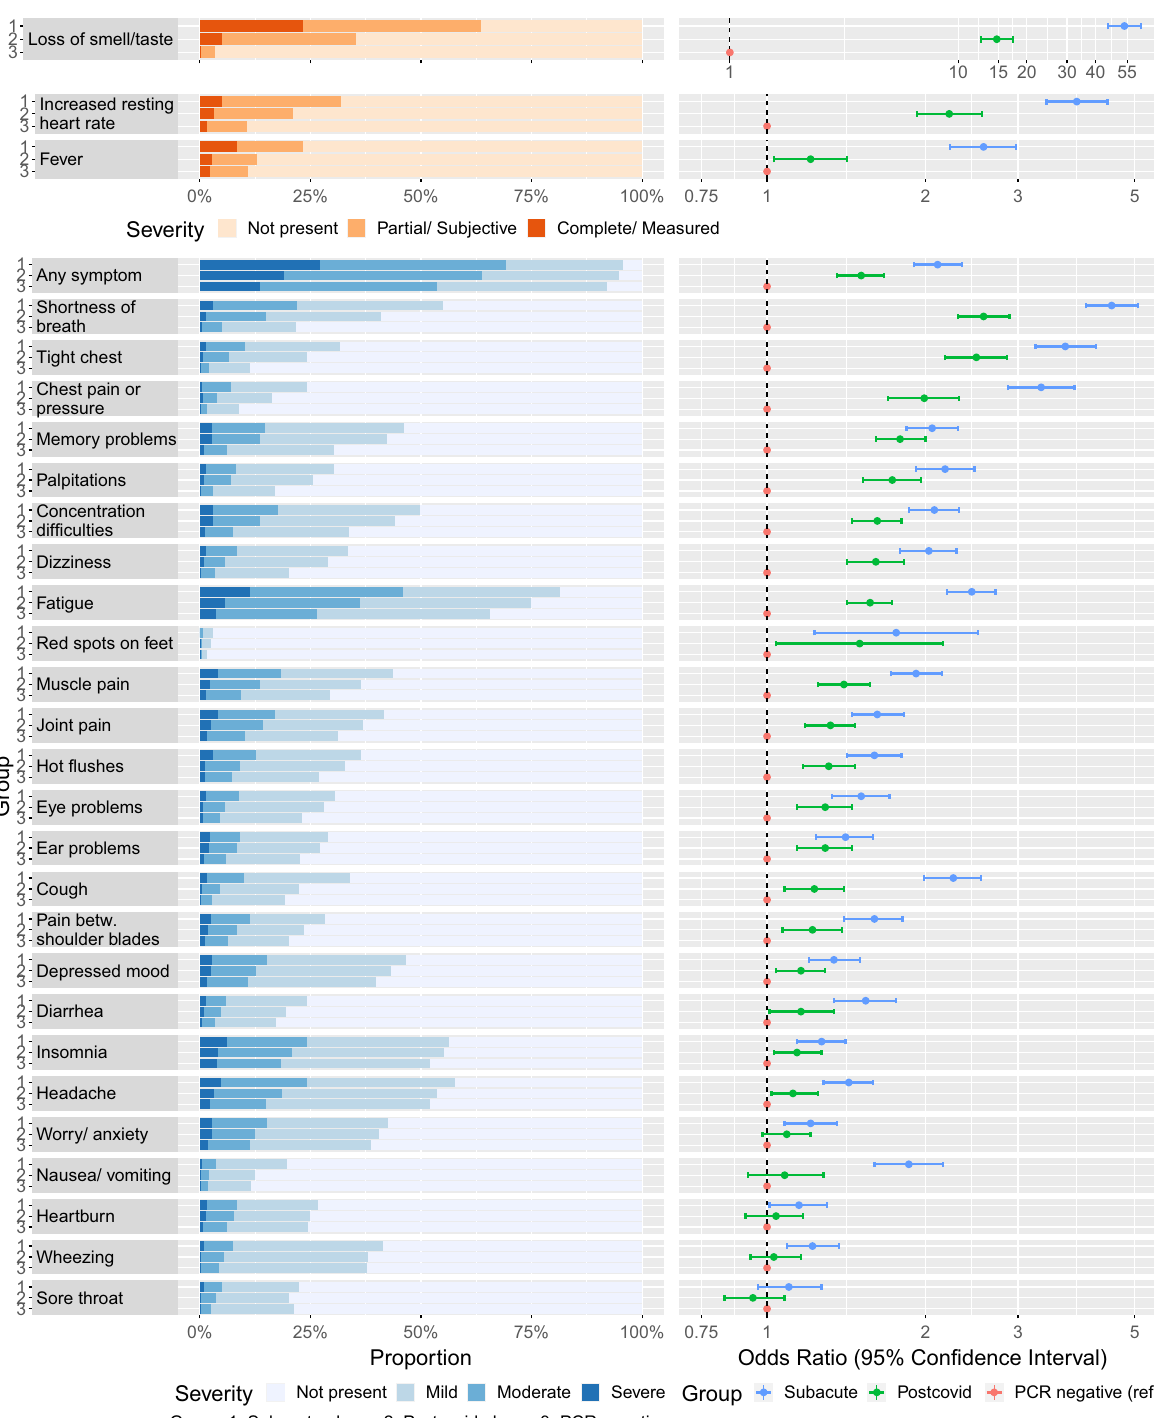
Group: 1. Subacute phase. 2. Postcovid phase. 3. PCR negative. Figure 2. Symptoms and signs as reported by study participants according to subgroup. Left panel: Proportion with each severity level of symptoms and signs among study participants [(1) Subacute phase, (2) postcovid phase, (3) PCR negative]. Right panel: Odds ratio of higher severity of each symptom and sign in SARS-CoV-2 positive in the subacute (blue, > 4 weeks and ≤ 12 weeks from positive PCR) and postcovid (green, > 12 weeks from positive PCR) phase compared to PCR negative participants (red, reference category). Odds ratios are from univariable ordinal logistic regression analyses. The scale is